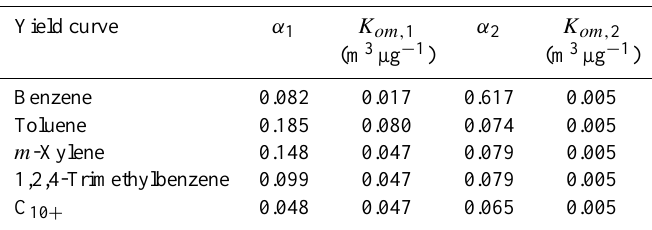
Table 2. Two-product yield curve fitting parameters.